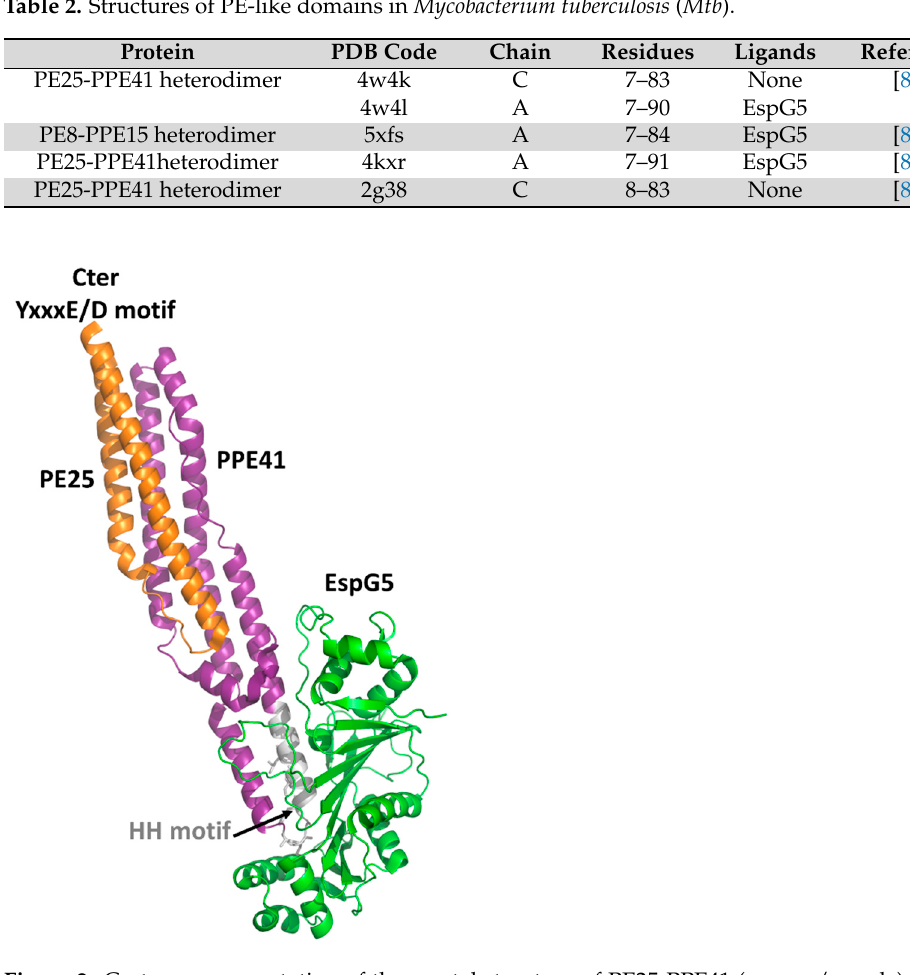
Figure 2. Cartoon representation of the crystal structure of PE25-PPE41 (orange/purple) ternary complex with the chaperone EspG5 (green). The signature ESX secretory motif YxxxE/D is located at the C-terminal side of PE25 (orange), whereas the EspG5 binding region is located on the HH motif of PPE41 (gray) [83].